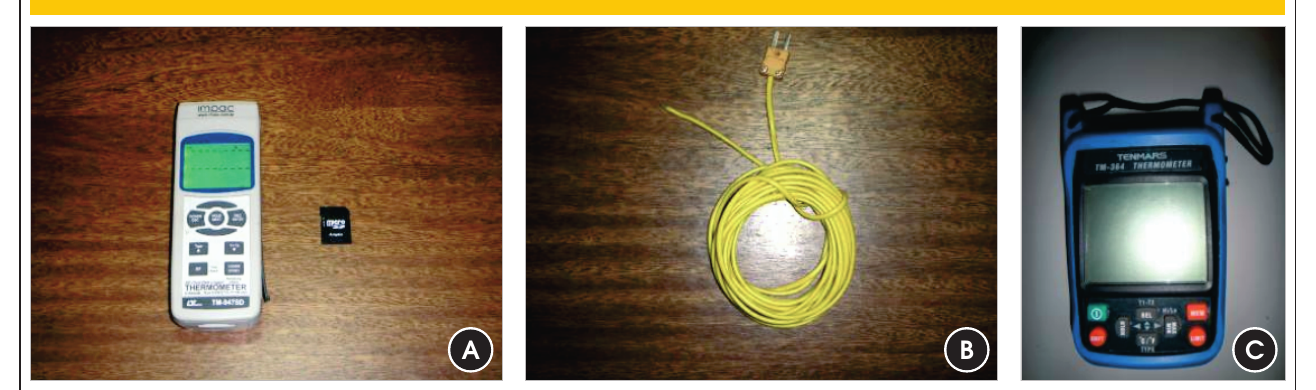
Figure 2 – Instrumentation used to monitoring of temperatures reached by the pile caps: a) Portable digital datalogger, b) Termocouple, c) Digital thermometer